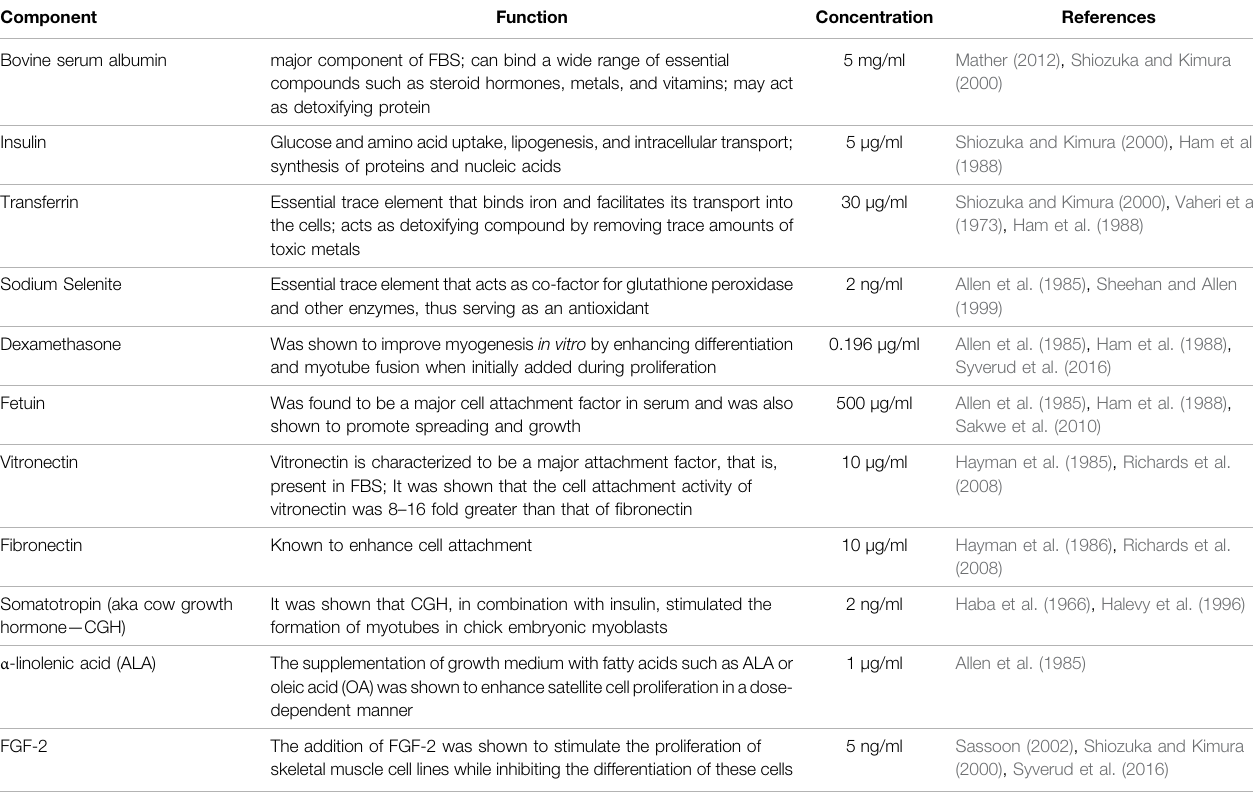
TABLE 2 | Overview of the fi rst formulation components with indication of their respective functions, fi nal concentrations and references. Component